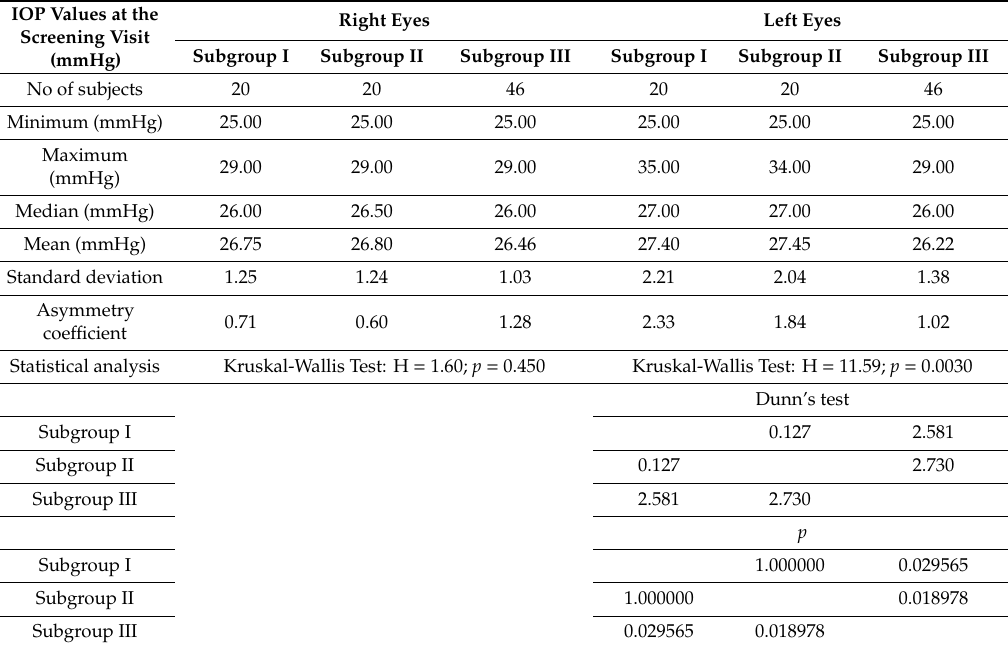
Table 7. IOP measurements values analysis in the study participant’s right and left eyes at the screening visit.